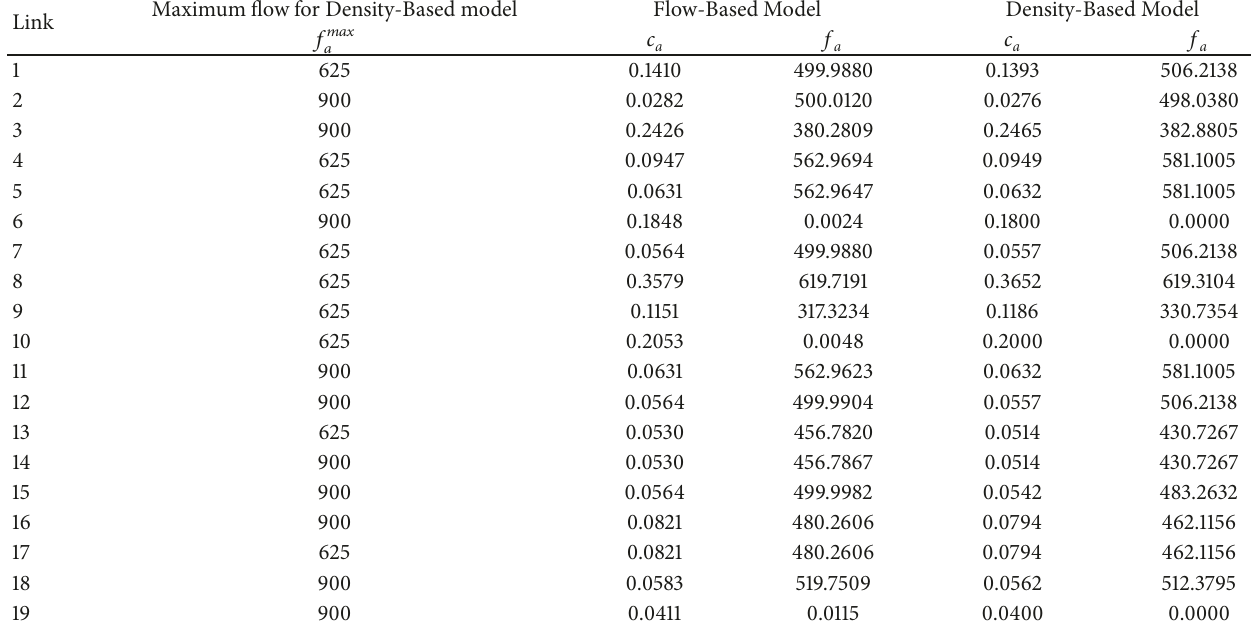
Table 8: Equilibrium Link Assignments, Both Approaches (low congestion).